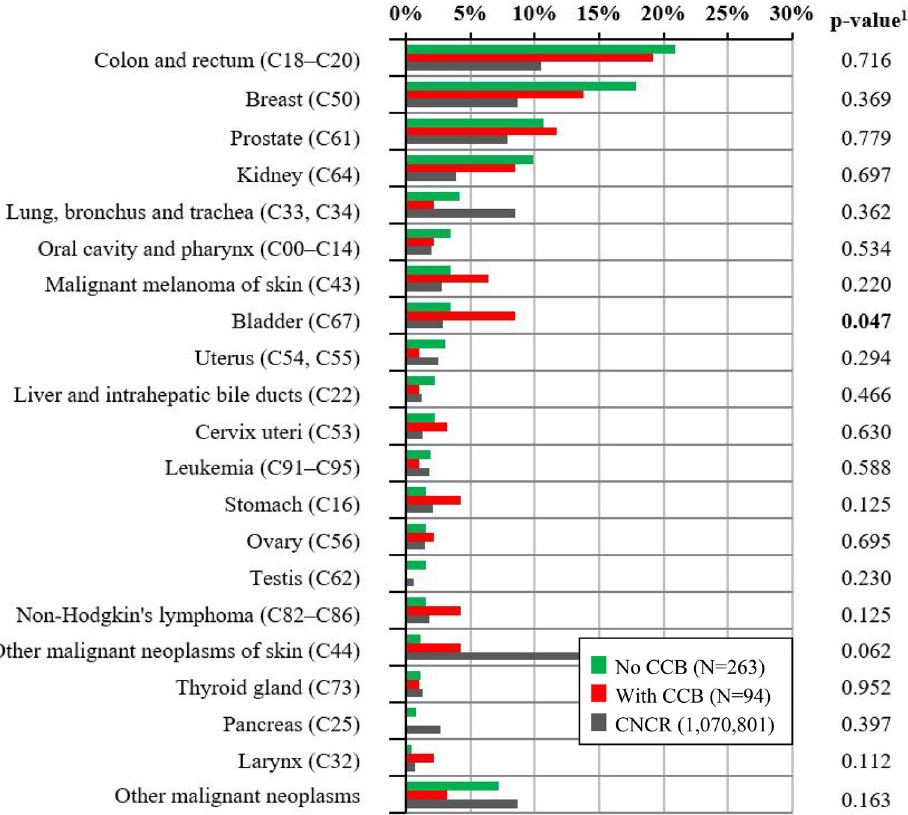
Figure 1. Occurrence of second primary malignancies with respect to use of calcium channel blockers. Only SPMs with a known date of diagnosis were considered (the date of diagnosis was not available for 7 SPMs). SPMs second primary malignancies, CCB calcium channel blocker, CNCR Czech National Cancer Registry (2003–2016). 1 p-value of N-1 Chi-squared test for group no calcium channel blockers and group with calcium channel